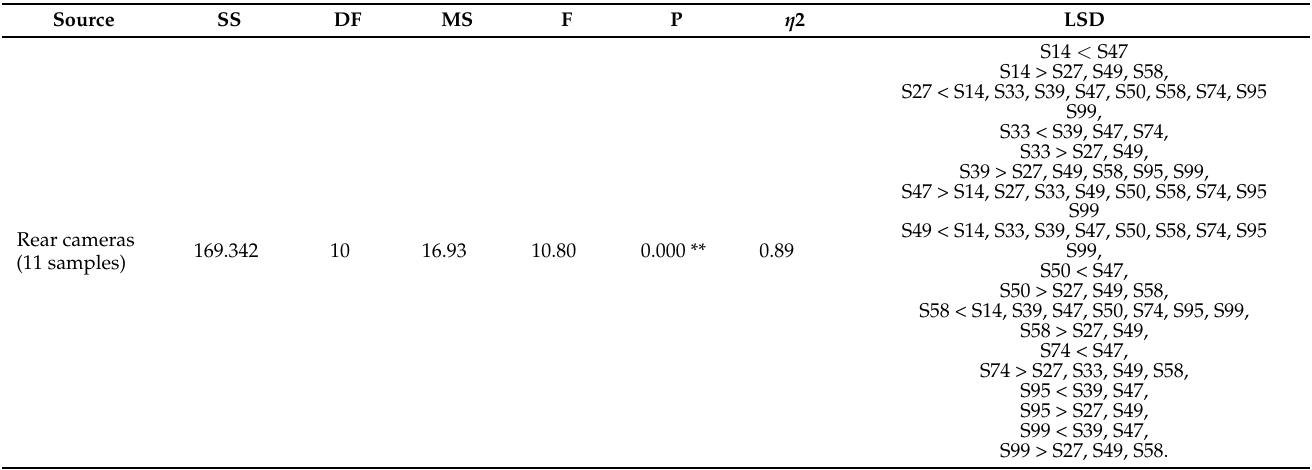
Table 13. The results of the general linear